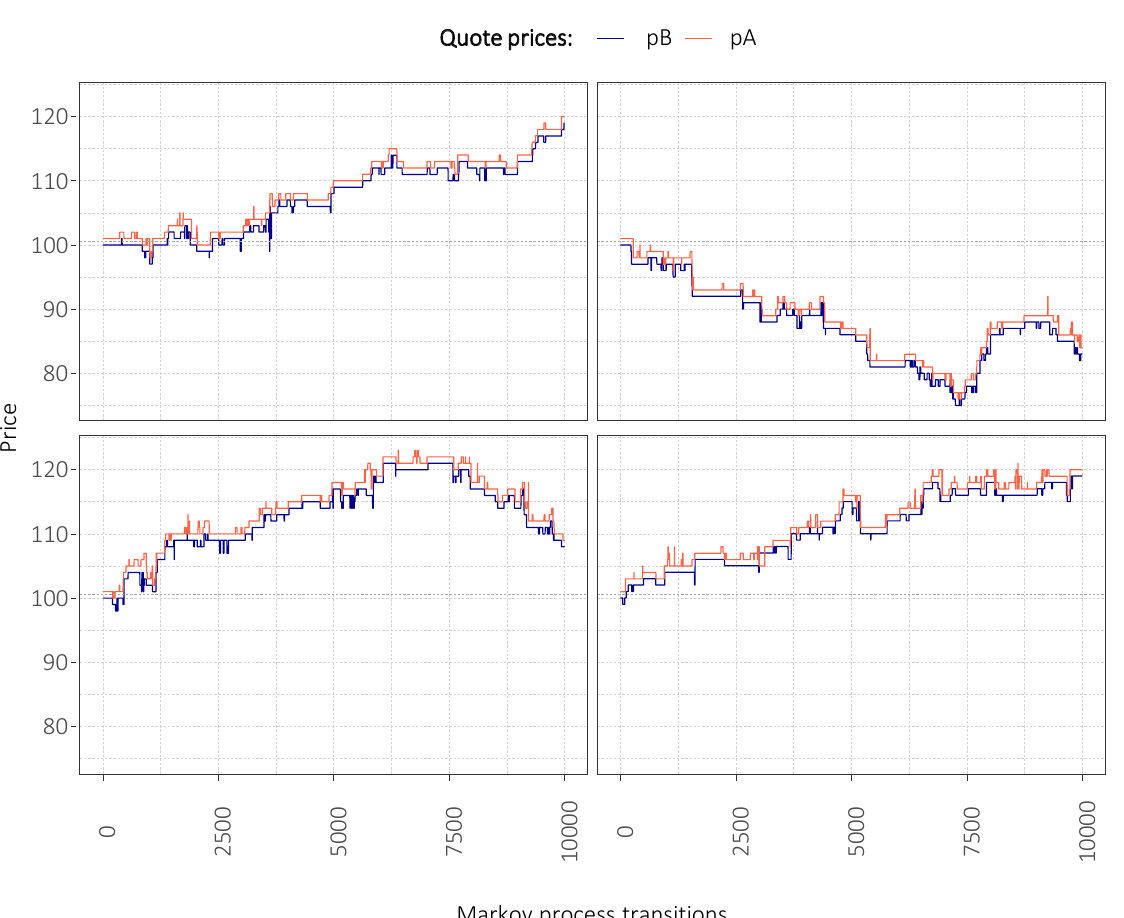
Figure 2. Examples of simulated price